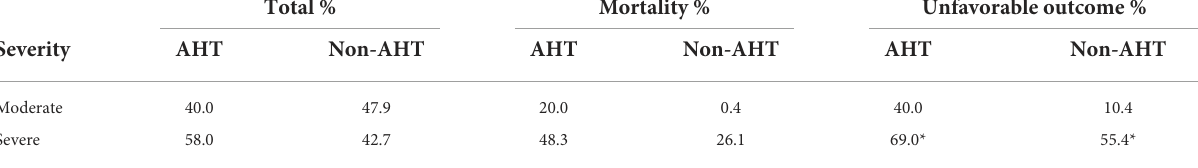
TABLE 6 AHT vs. TBI